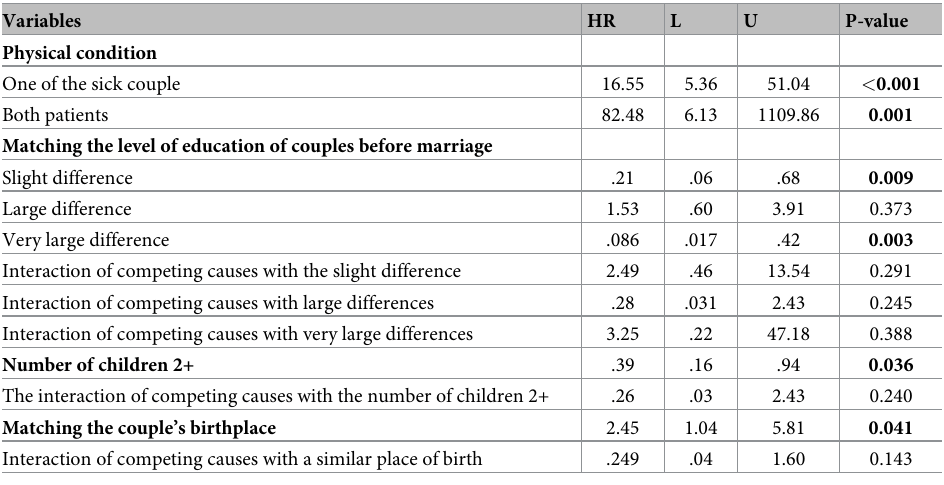
Table 4. Results of Lunn-McNeil multivariate analysis for the competing cause of traditional mode of being famil- iar with spouse. Variables HR L U P-value Number of children 2+ .14 .03 .62 0.010 The interaction of competing causes with the number of children 2+ Matching the level of education of couples before marriage Slight difference .46 Large difference Very large difference Interaction of competing causes with a slight difference Interaction of competing causes with large differences Physical condition One of the sick couple Both patients Interaction of competing causes with one of the sick couples .86 Interaction of competing causes with both patients 3.11 .69 13.95 0.139 LR Chi2(11) = 36.47, Log likelihood = -173.78092, P-Value = 0.0001.